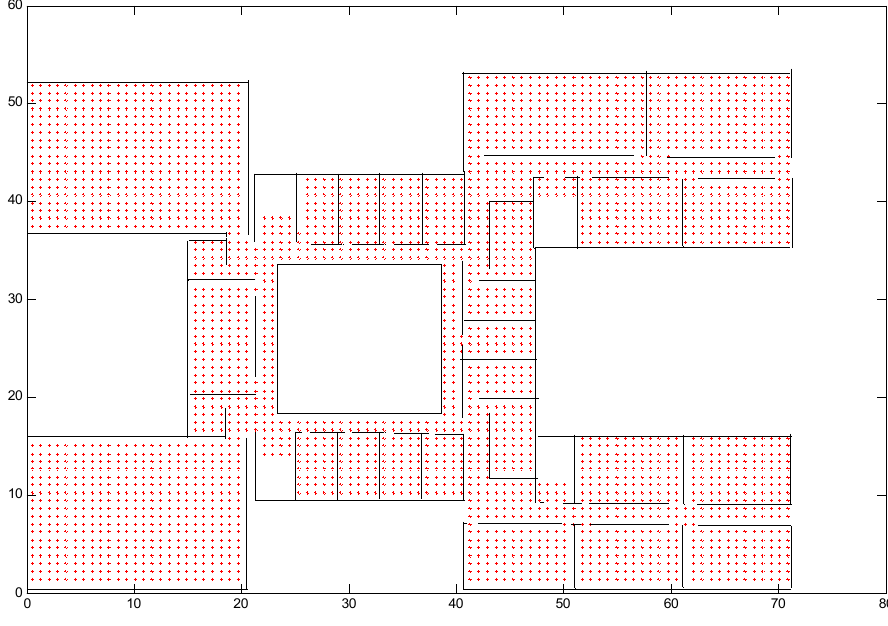
Figure 2. States in Economics and Management Building.